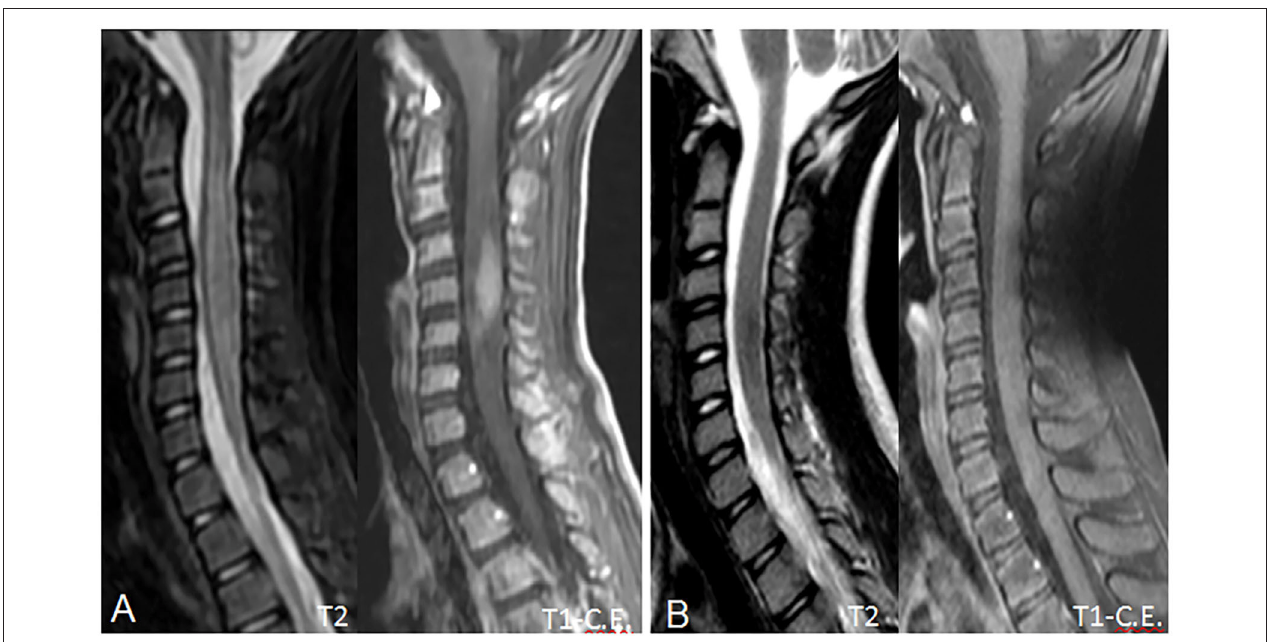
FIGURE 2 | Follow-up MRI scans at 20 (A) and 55 (B) days, showing progressive reduction of the spinal cord swelling and contrast enhancement. In (B) , contrast enhancement has completely regressed, due to blood-brain barrier restoration, and the spinal cord shows a near-normal appearance with no residual disease. No spinal cord atrophy is